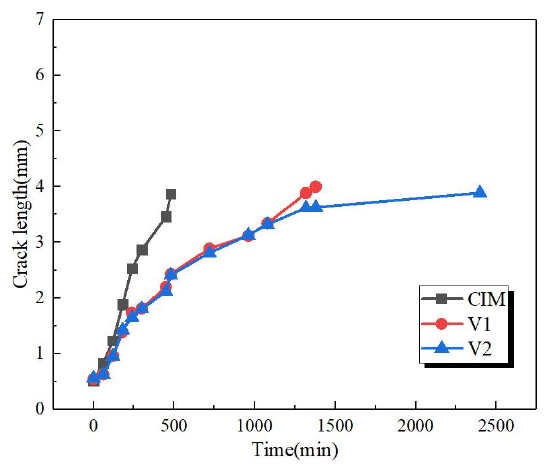
Figure 7. The crack length versus time of all the samples during the process of slow crack growth (SCG).